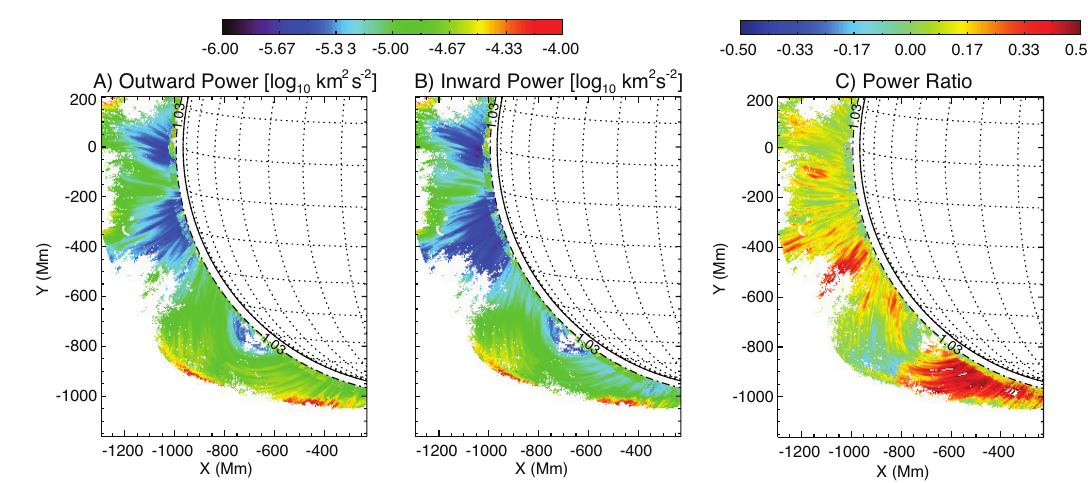
Figure 21: A map of the outgoing and ingoing power seen in 5-minute period coronal waves for a section of the corona. The oscillations are measured with the [Fe xiii ] 1075 nm Doppler shift, and the waves are classified as outgoing and ingoing using their propagation direction. The outgoing waves are measured to have more power than the ingoing waves. Image reproduced with permission from Tomczyk and McIntosh (2009), copyright by